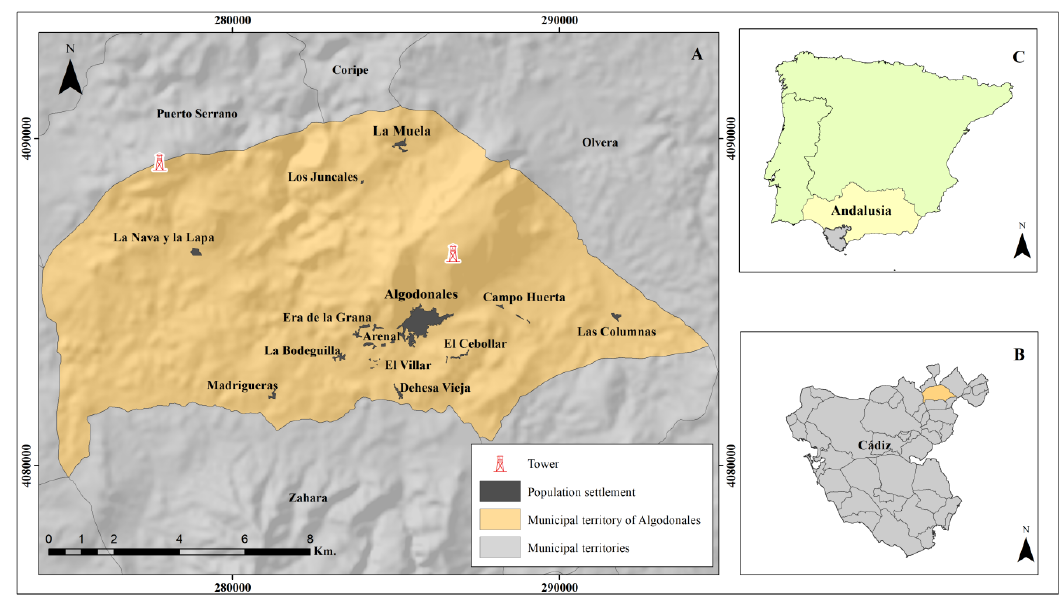
Figure 1. Study area ( A ) Municipality of Algodonales; ( B ) Algodonales in the province of Cadiz; ( C ) Province of Cadiz in Andalusia (Spain).